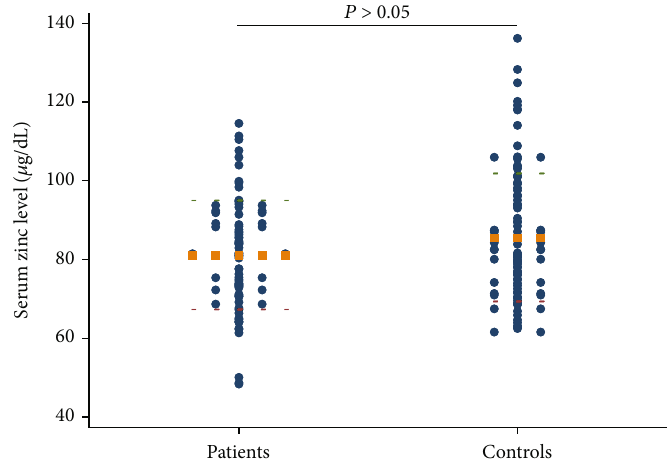
Figure 1: Comparison of the serum zinc levels between the patient group and the control group (Student ’ s t -test). The round dots show values of serum zinc level, and the orange square dot lines show mean values.